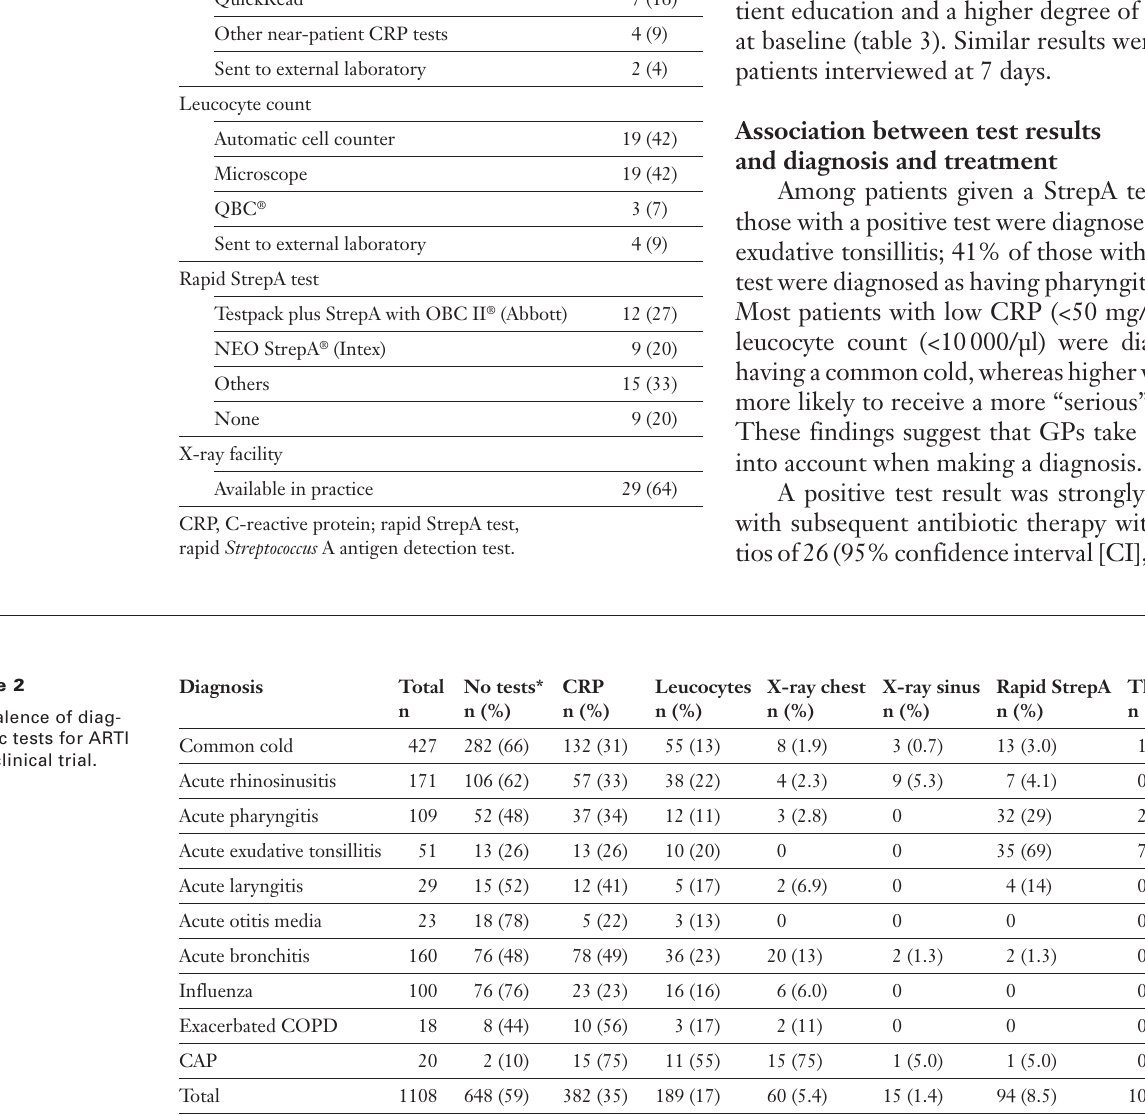
Overview of diagnos- tic tests used for ARTI in general prac- tice.